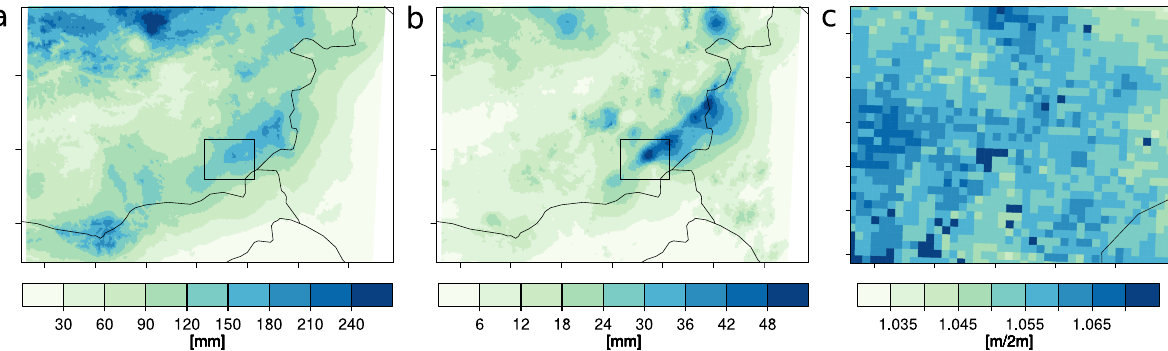
Fig. 2 Actual rainfall and preconditioning soil moisture over the South – Eastern Alpine forelands. a Maximum 5-day aggregated rainfall ending between 22 and 26 June 2009, and b maximum 3-h rainfall between 22 and 26 June 2009 recorded in the INCA data set 64 . c Hindcast simulation of maximum 2 m-integrated soil moisture on the day prior to the beginning of the corresponding 5-day rainfall aggregation period. Occurrence dates and thus time periods are chosen individually for each grid box (see Methods for the exact trigger de fi nition for calibrating the statistical model using the landslide dates, which can only be derived for locations where landslides have occurred and thus differ slightly from the de fi nition used for these maps). All panels display the domains used to calculate the delta change factors for the corresponding predictor (13.82E – 17.31E and 46.16N – 48.01N for precipitation; the target region for soil moisture, marked by the black box in a , b , see also Supplementary Fig.